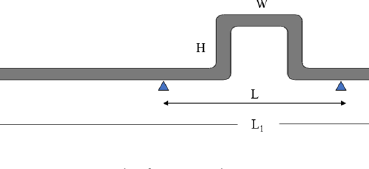
Figure 1: Symmetrical Expansion Loop.